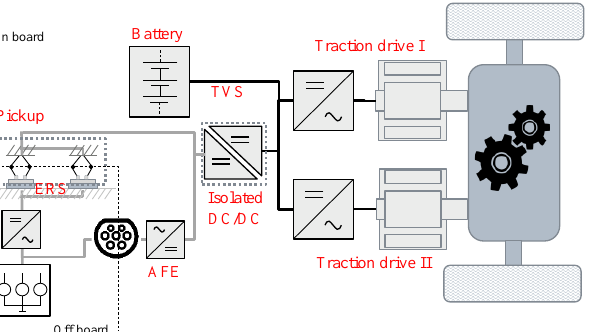
Figure 2. Schematic view of a powertrain with a high power DC-DC converter interface between the TVS and ERS (HSETS)